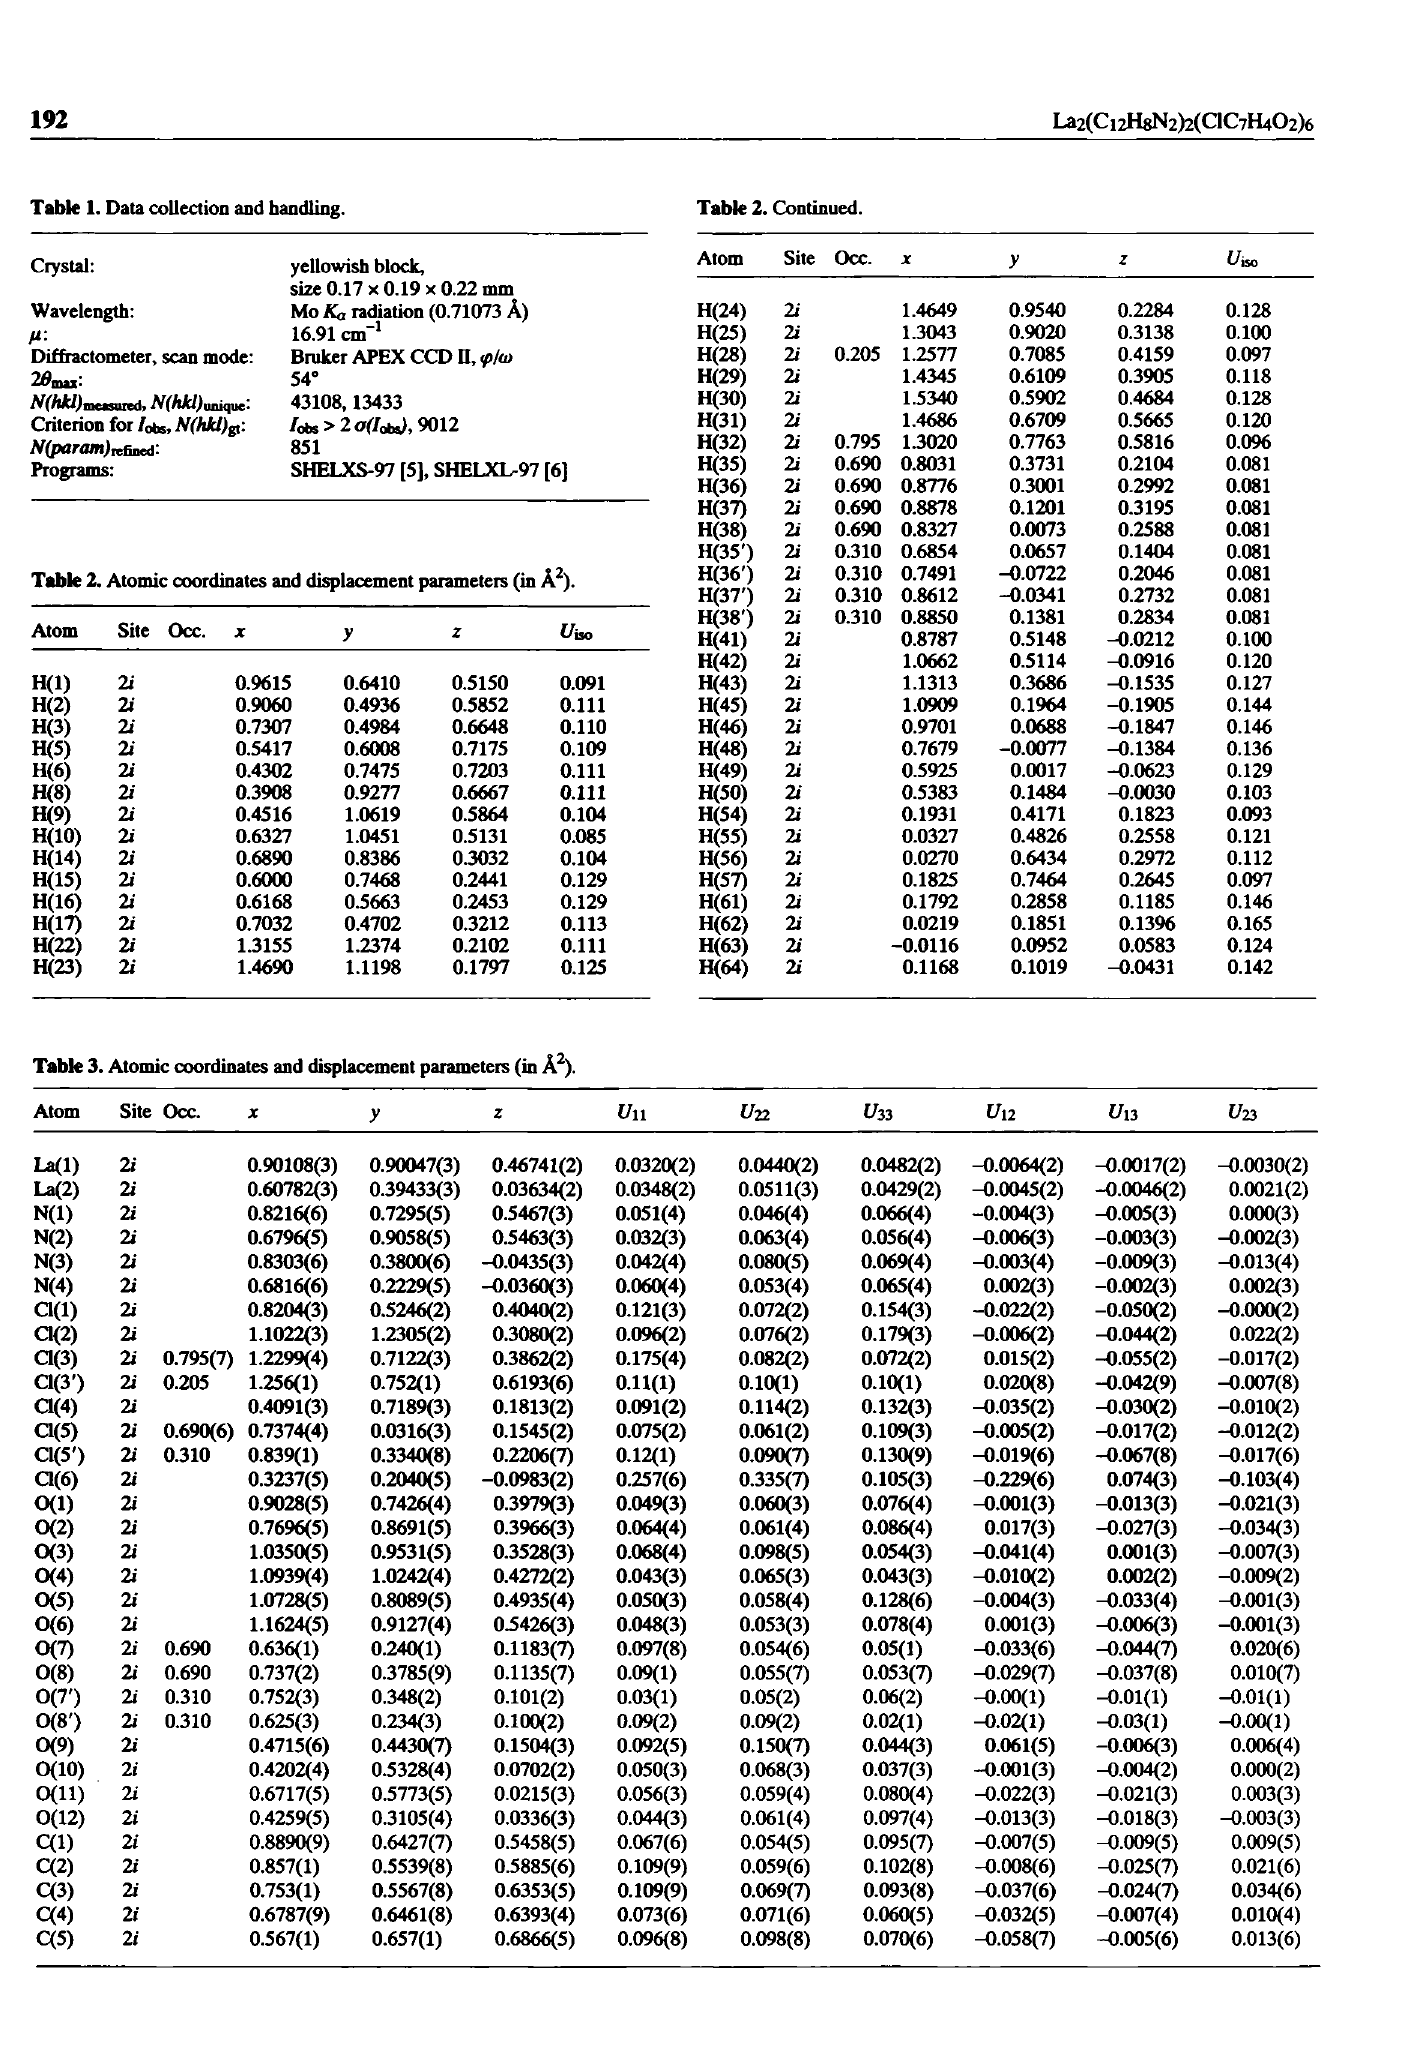
Table 3. Atomic coordinates and displacement parameters (in A 2 ). Atom Site